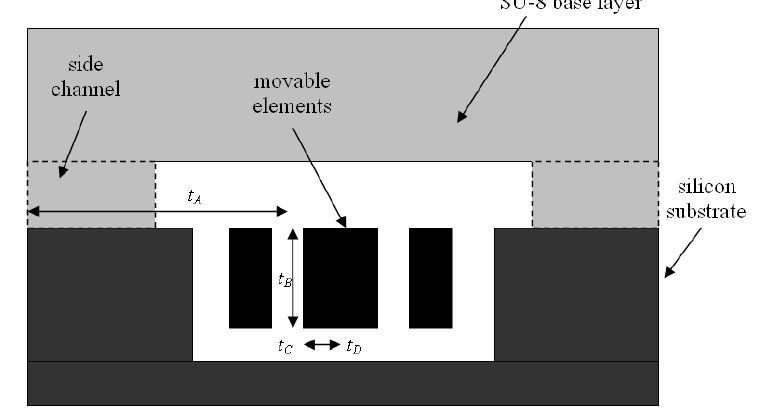
Figure 4. Schematic diagram of a base encapsulated MEMSTech 50g accelerometer showing total etch time needed to completely release the accelerometer movable elements.